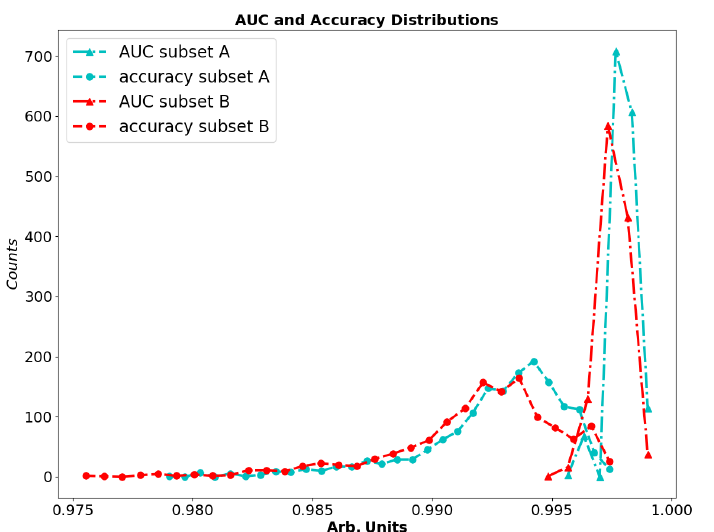
Figure 6. Distribution of the accuracy and AUC for the best 1400 classifiers on dataset A and